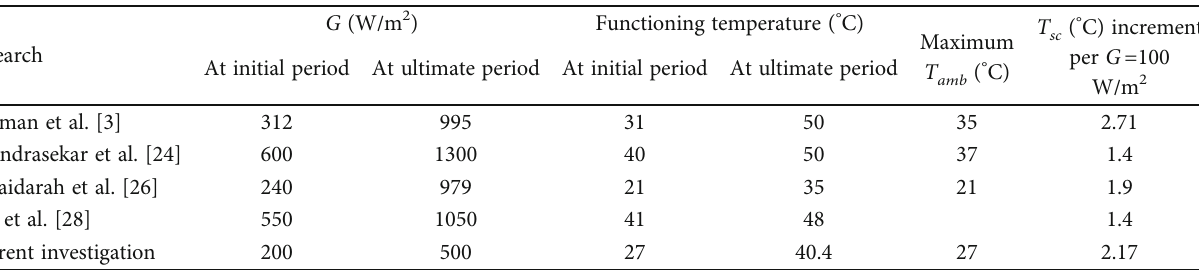
Figure 18: Outcome of (a) G , (b) V , (c) T , and (d) partial shading on PVT overall e ffi ciency. in amb Table 4: Comparison of PVT cell temperature among di ff erent